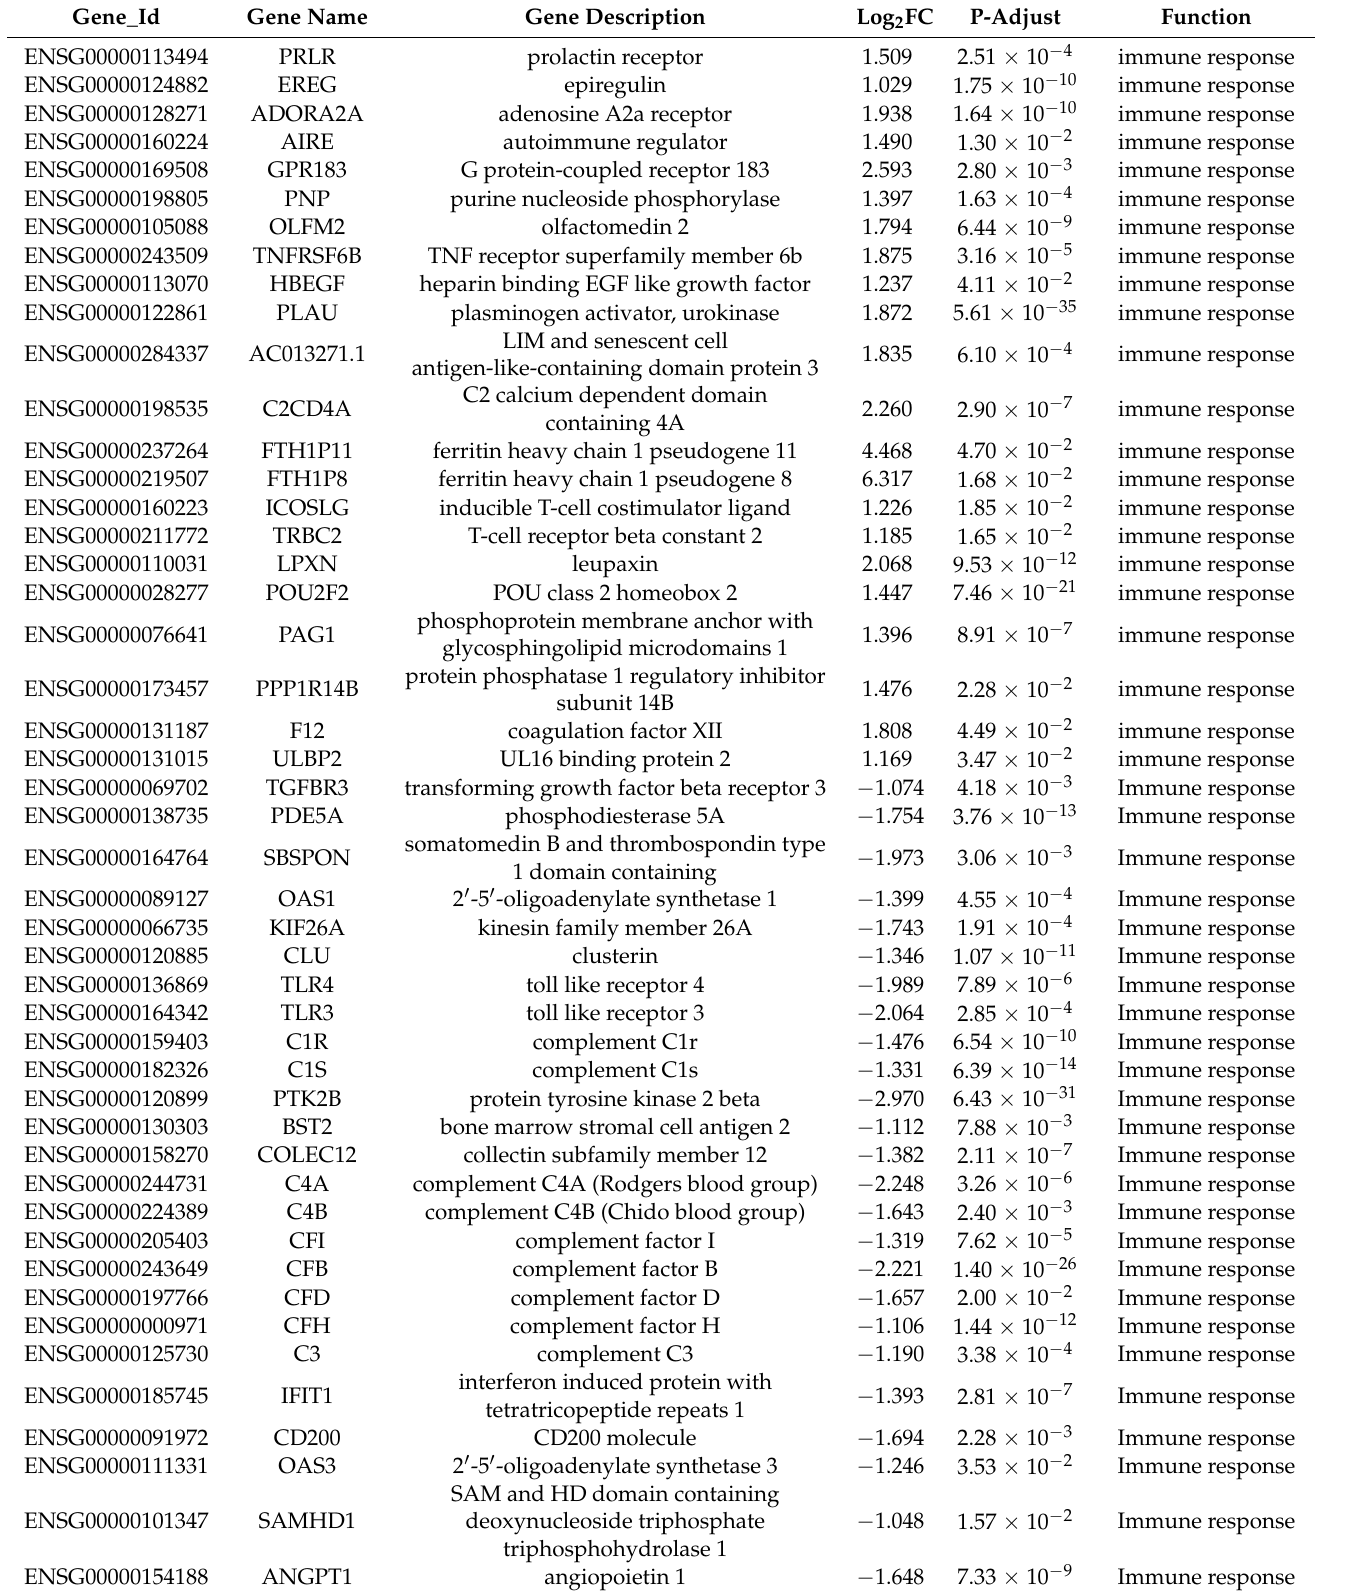
Table 4. Functional characterization of up/downregulated differential expressed genes in H 2 O 2 - induced